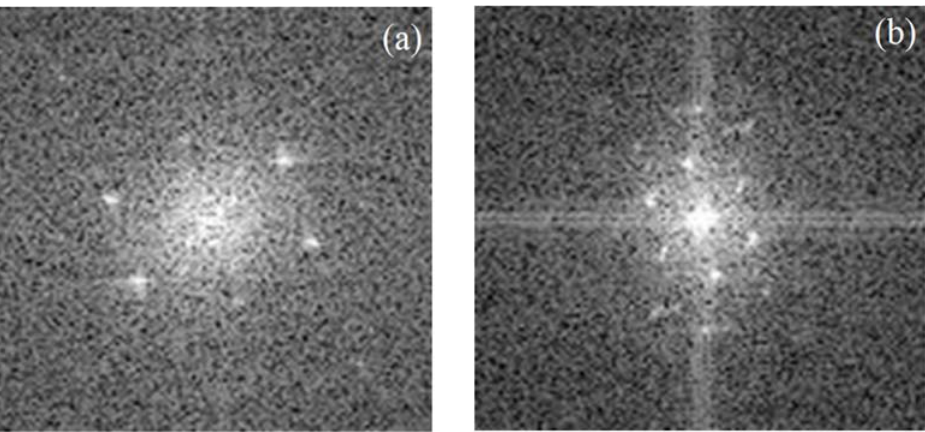
Figure 7. The selected area electron diffraction (SAED) for Fe ‐ FinFET ( a ) before and ( b ) after hot carrier stress.